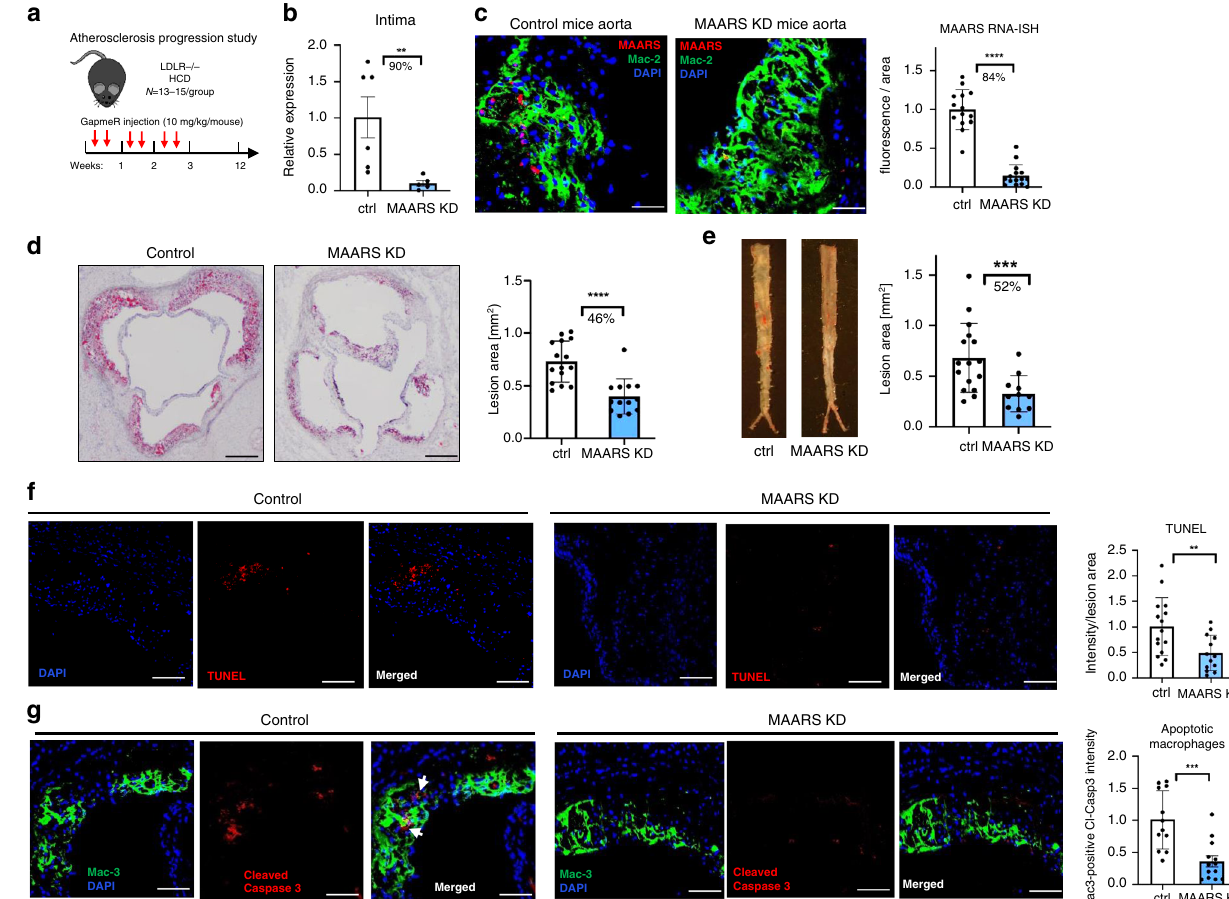
Fig. 2 In vivo knockdown of MAARS inhibits atherosclerotic lesion formation. a LDLR − / − mice were i.v. injected with vehicle control gapmeR ( n = 15) or MAARS gapmeR ( n = 13) twice per week (7.5 mg kg − 1 per injection per mouse) and placed on HCD for 12 weeks. b Silencing of MAARS was assessed by RT-qPCR in RNA derived from the aortic intima ( n = 6 for control gapmeR group and n = 5 for MAARS gapmeR group). c RNA-ISH representative images and quanti fi cation of MAARS knockdown in Mac2 co-stained aortic sinus from control and MAARS KD groups of mice. Representative images and quanti fi cation for Oil-Red O staining in the lesions of aortic sinus ( d ) and in the descending aorta ( e ) of the control ( n = 15) and MAARS KD ( n = 13) mice. f TUNEL (red) staining was detected in the aortic sinus of the control ( n = 15) and MAARS knockdown (KD, n = 13) groups of LDLR − / − mice fed HC, counterstained with DAPI (blue), and quanti fi ed as total red fl uorescent staining per lesion area. g The aortic sinus was co-stained with cleaved caspase-3 (red) and Mac-3 antibodies (green) and the Mac3-associated caspase-3 fl uorescence was quanti fi ed in the aortic sinus of the control ( n = 15) and MAARS KD ( n = 13) mice. For all panels, values are mean ± SD; * p < 0.05; ** p < 0.01; *** p < 0.001; **** p < 0.0001; ***** p <